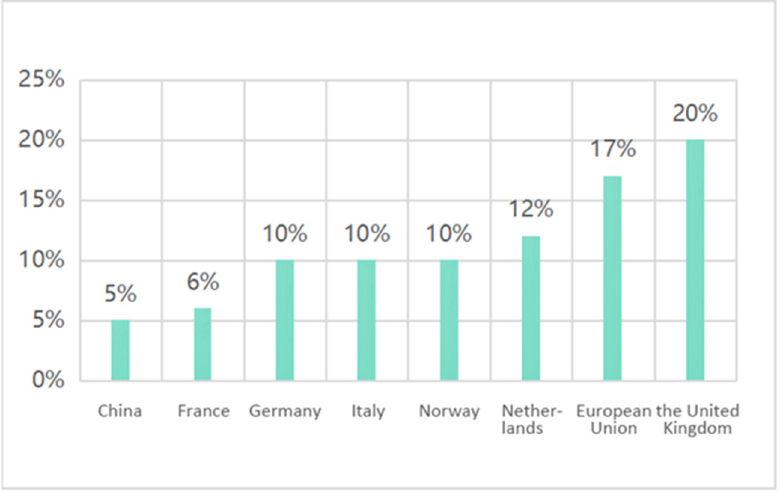
Figure 1. Mole percentage of hydrogen injected into natural gas pipelines, as studied by different countries’ demonstration projects.